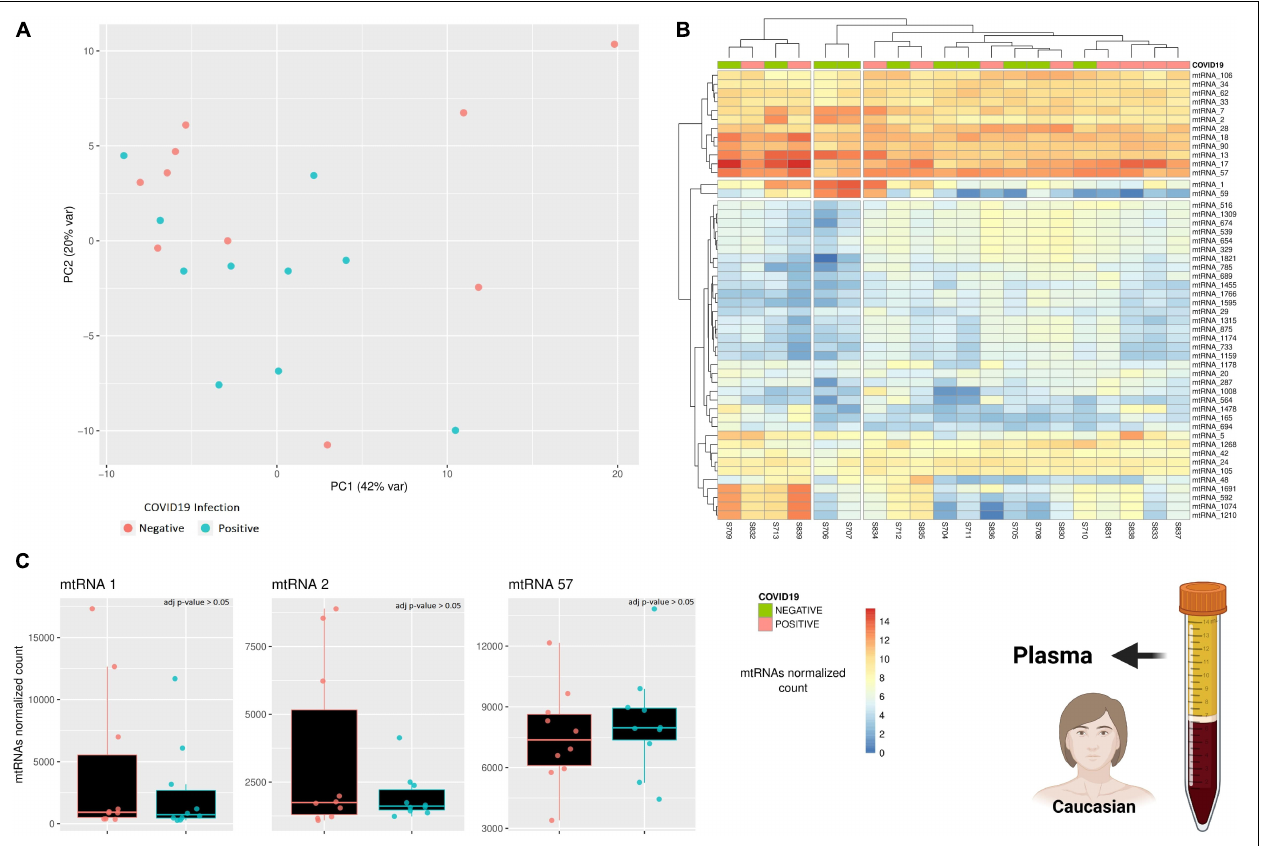
FIGURE 3 | A comparison across of small RNAs expression between COVID-19 patients and age-matched healthy individuals. (A) The PCA shows how similar is the general small mitochondrial RNAs expression across patients and healthy individuals. The variability of each principal component is in the axis label. (B) The heatmap compare the expression of small RNAs encoded on the mitochondrial genome. The rows represent clusters of small RNAs (mtRNAs), while the columns are individuals. (C) The barplot compare the expression of several mtRNAs that are differentially transcribed across the three clinical stages. Each datapoint represent a different patient or healthy individual. The icons in the figure on the right-side highlights from which population and type of sample the data are generated. The icons have been made using